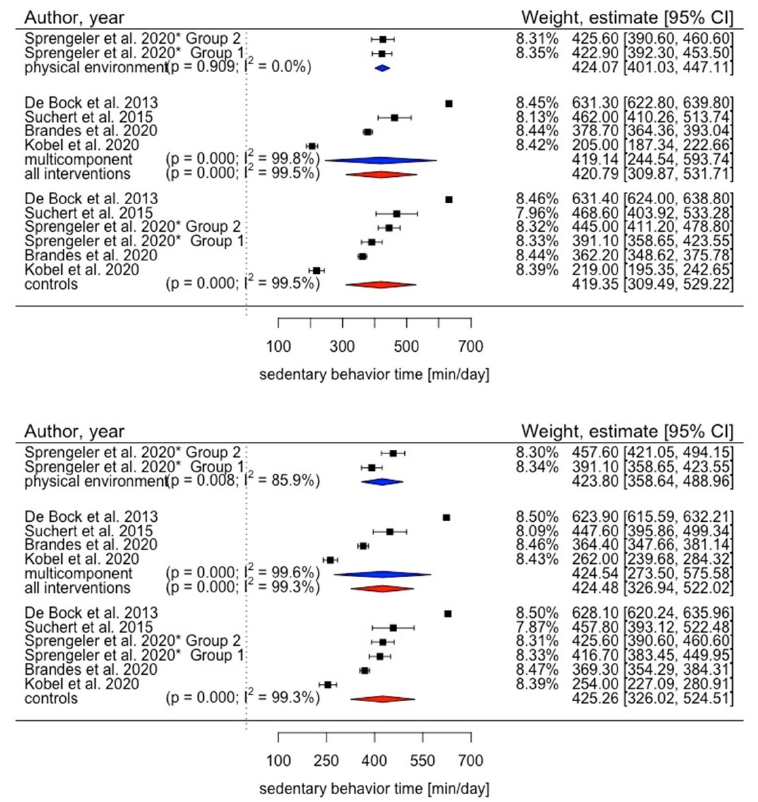
Figure 3. Results of meta-analysis in children [75,76,78,87,88]. Top: sedentary time at baseline. Bottom: sedentary time at study end. * Sprengeler et al., 2020 implemented a cross-over design, therefore each study group served as intervention and control group once. Blue depicts summaries for each intervention type; red depicts overall summaries for (any) intervention and control group